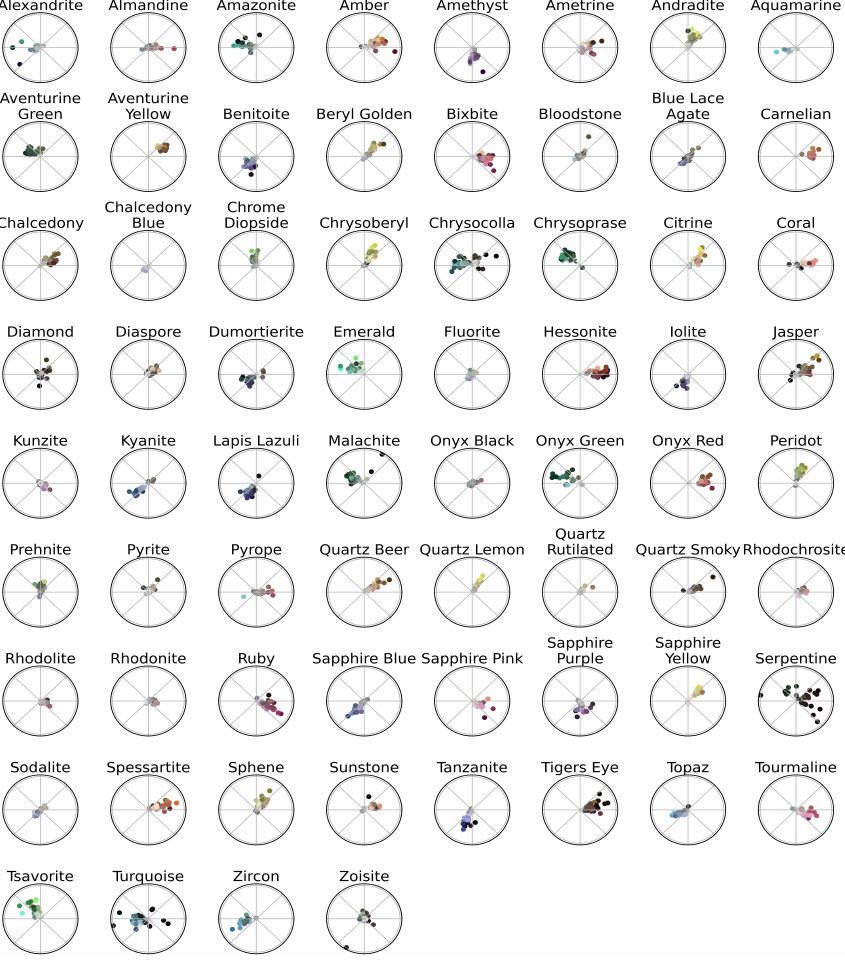
Figure 6. Distribution of median Hue and Saturation of gemstone images aggregated by class and displayed as polar scatter plots. It should be noted that the distribution of several gemstones is very similar, e.g., Emerald and